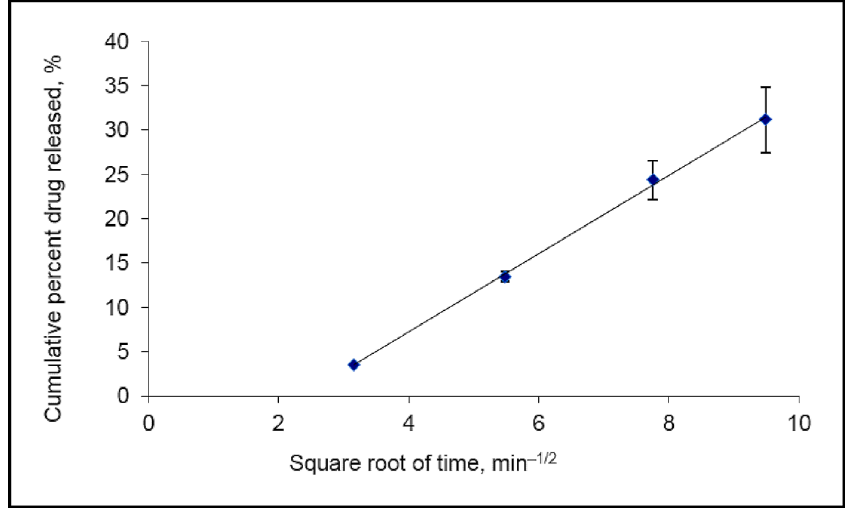
Figure 2. In vitro release profile of Lidocaine from Weblike film according to Higuchi’s plot. n = 5, Mean ± SD.